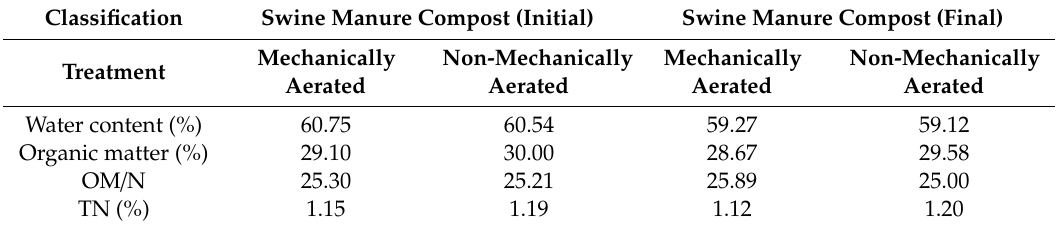
Table 2. Characteristics of pig manure used in this